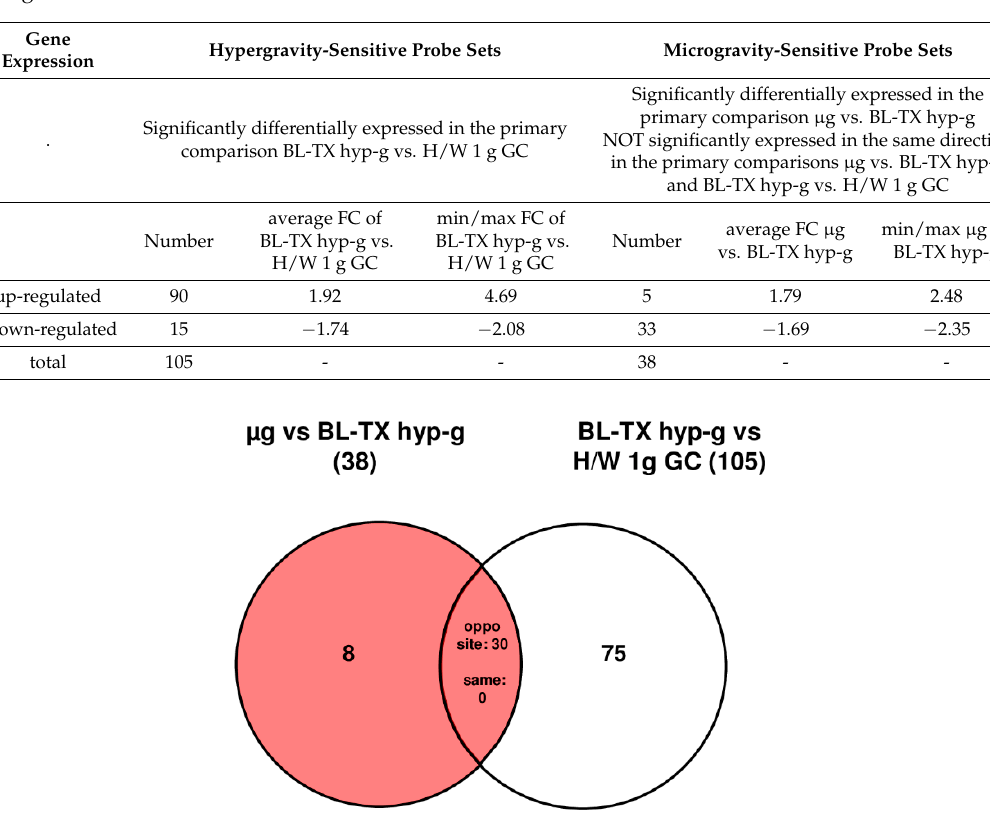
Table 10. Definition and numbers of hypergravity- and microgravity-sensitive probe sets that are differentially expressed in response to hypergravity or microgravity during TEXUS-49 sounding rocket flight in human U937 cells.